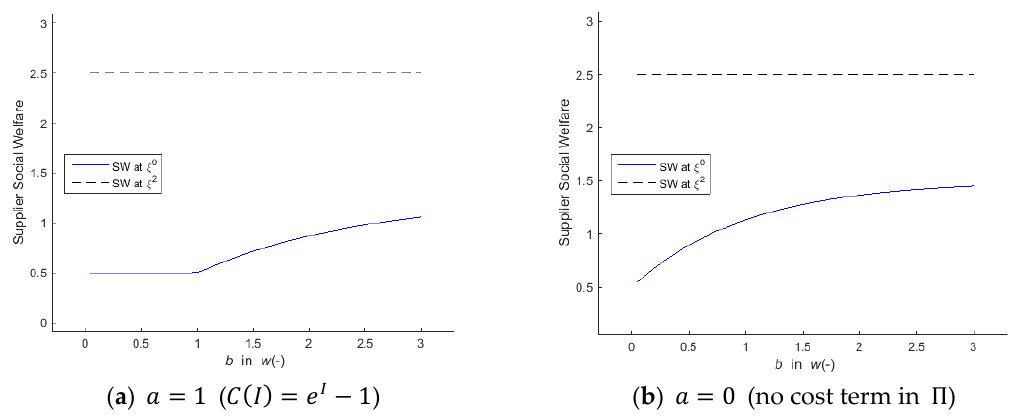
Figure 6. Suppliers ’ SW changes as the investment efficiency varies. Figure 6. Suppliers’ SW changes as the investment efficiency